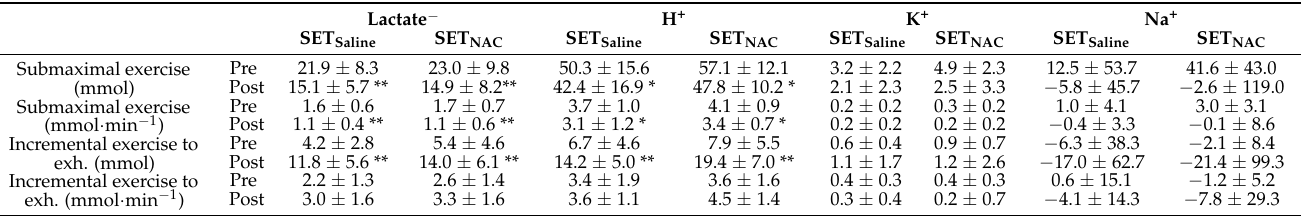
Table 3. Effect of speed endurance training (SET) on cumulated net leg lactate − , H + , K + , and Na + exchange during submaximal and intense